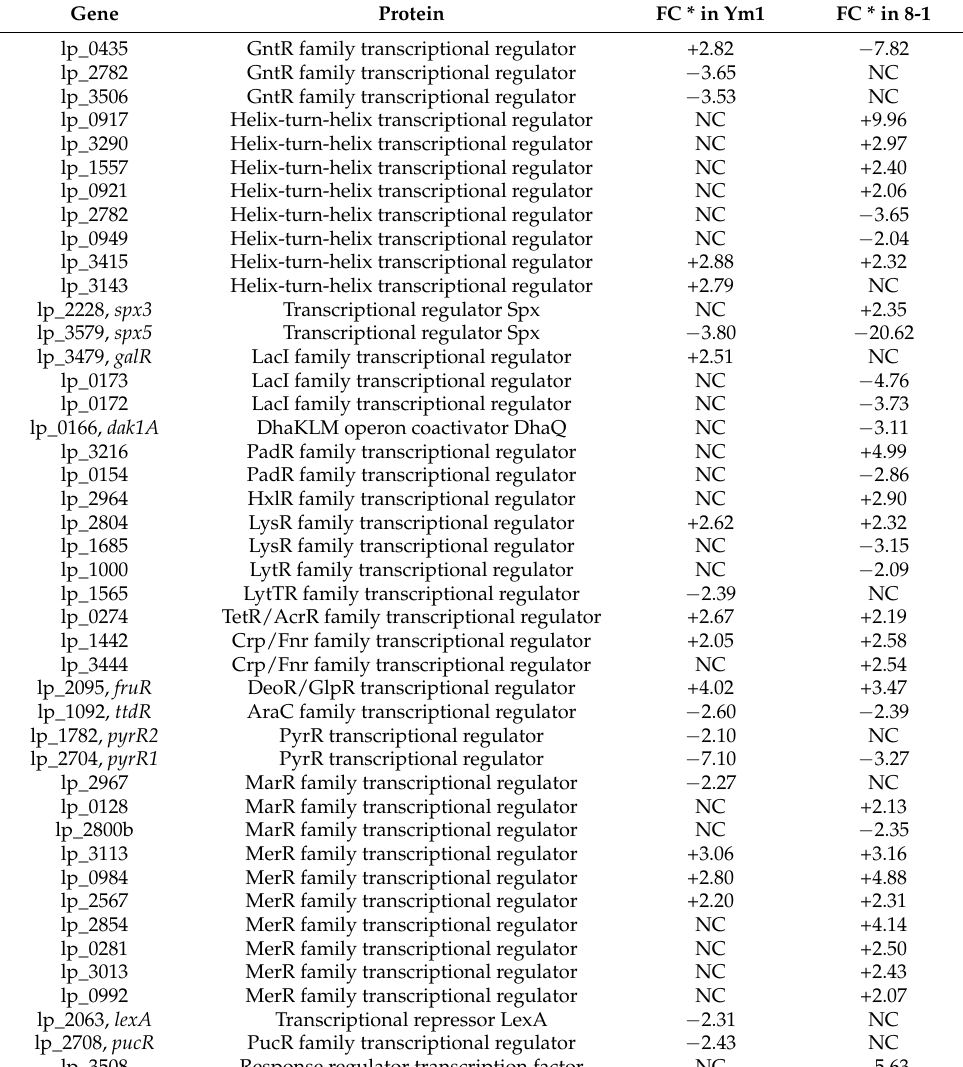
Table 4. Differentially expressed genes (DEGs) encoding transcriptional regulators in L. plantarum strains under butanol